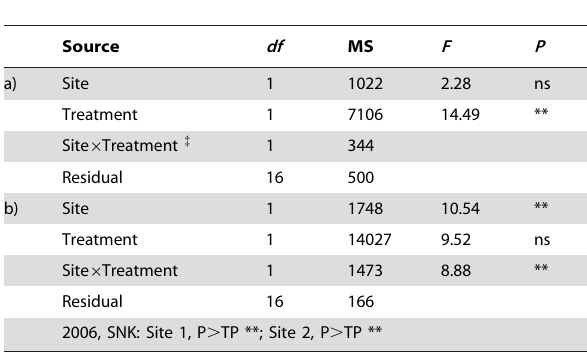
Table 2. Mean ( 6 SE; n =4) numbers of sea-urchins per treatment during the experimental exclusion of urchins and shade on reefs in 2009. {